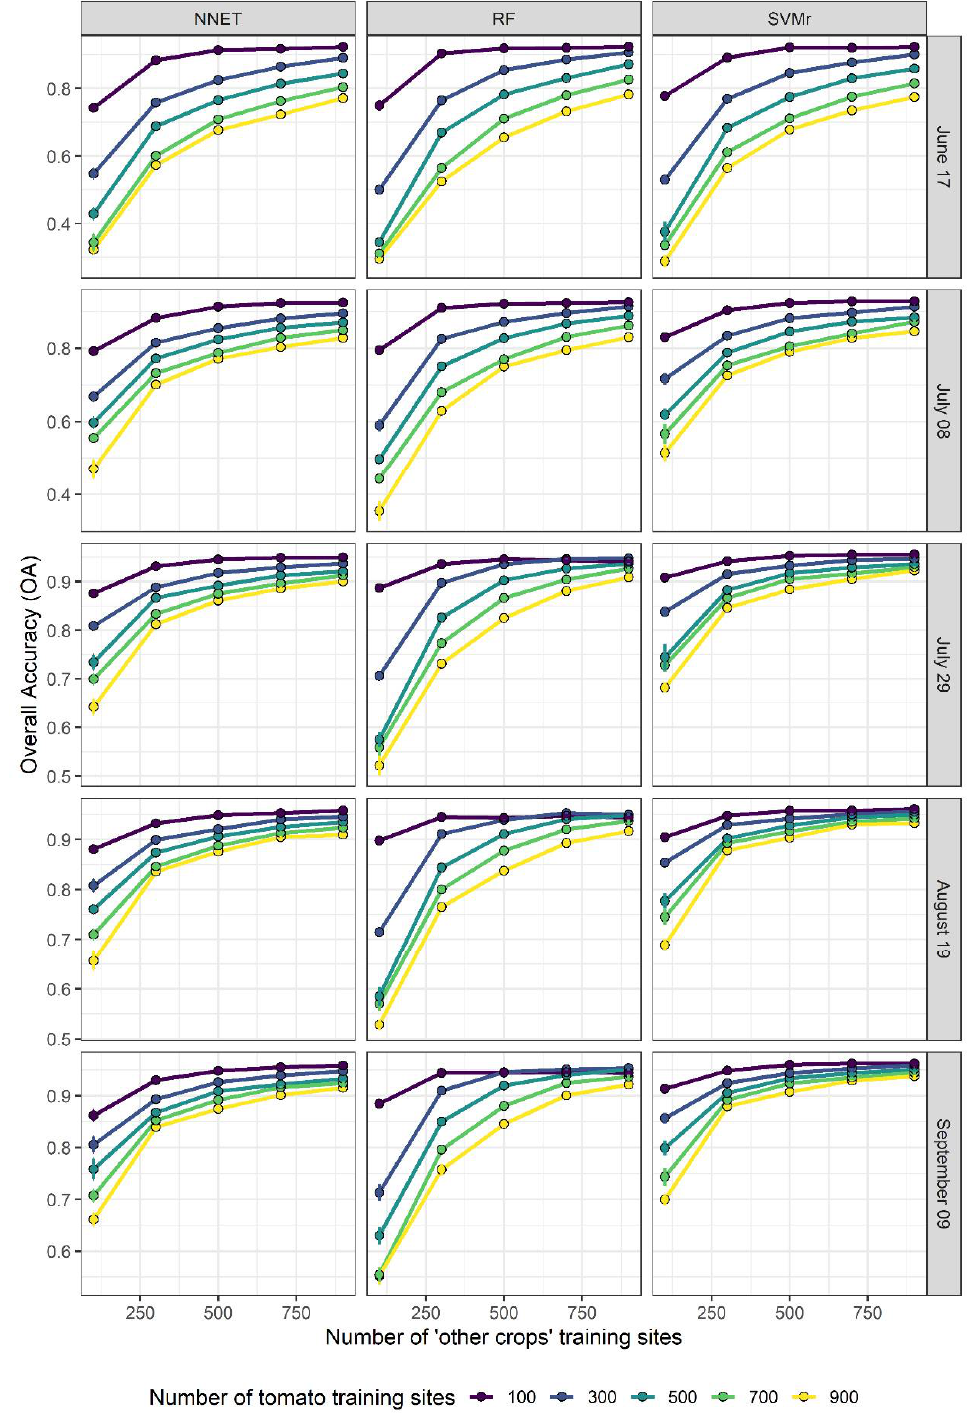
Figure 3. Overall Accuracy progress over the number of ‘other crops’ training sites at different number of tomato training sites and lead time.